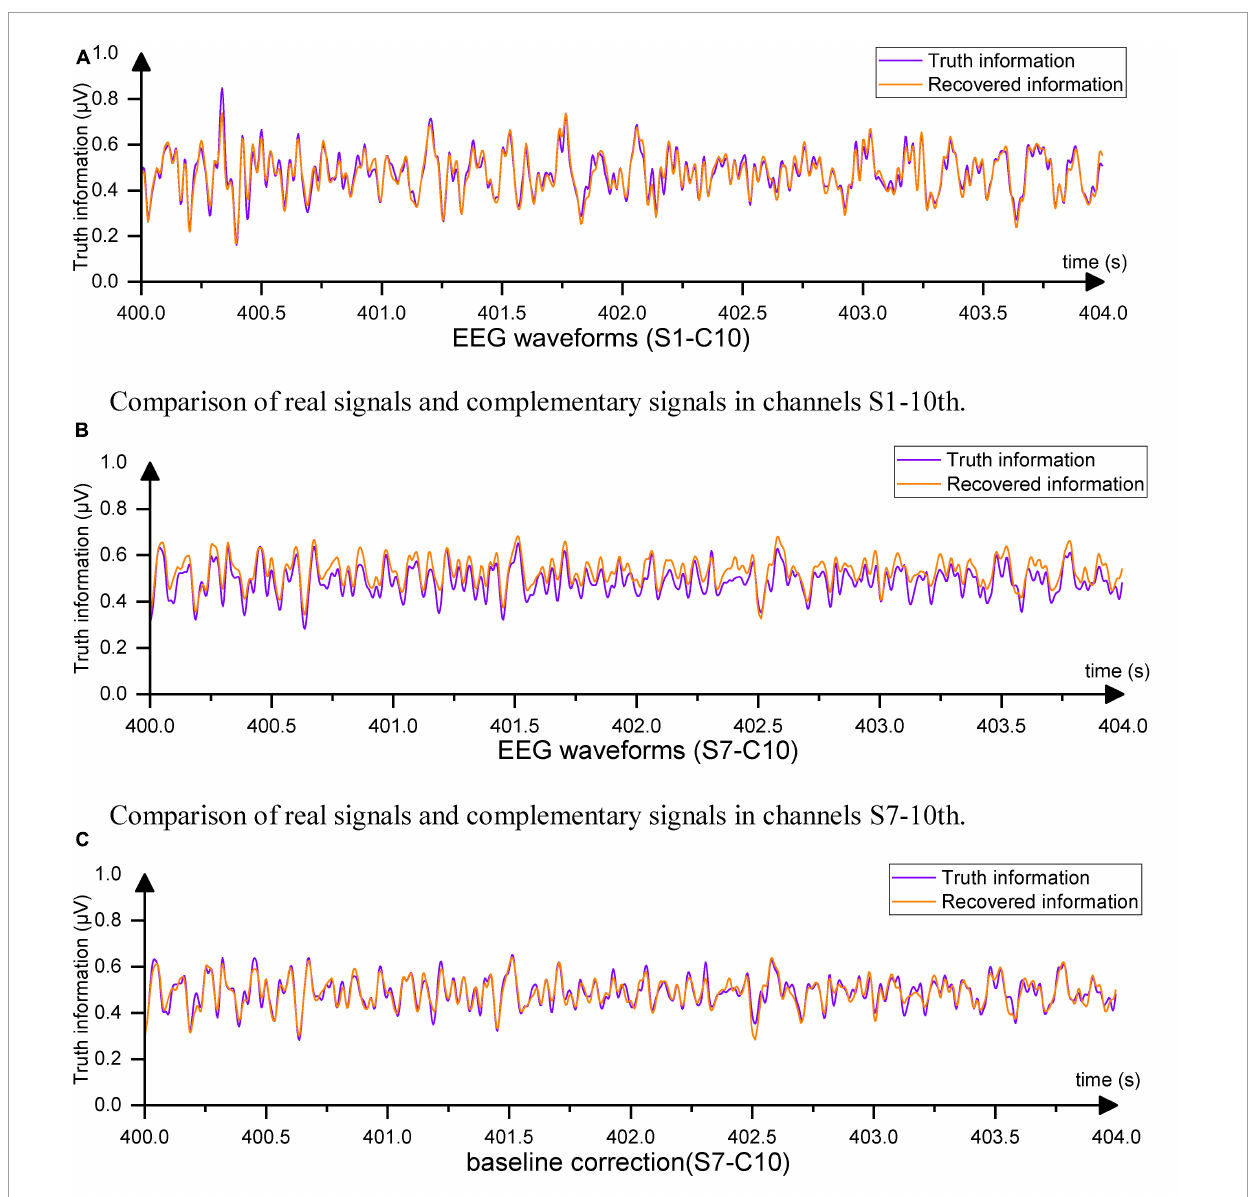
FIGURE5 Example of EEG waveformst. (A) Comparison of real signals and complementary signals in channels S1-10th. (B) Comparison of real signals and complementary signals in channels S7-10th. (C) Comparison of real signals and baseline-corrected complementary signals in channels S7-10th.